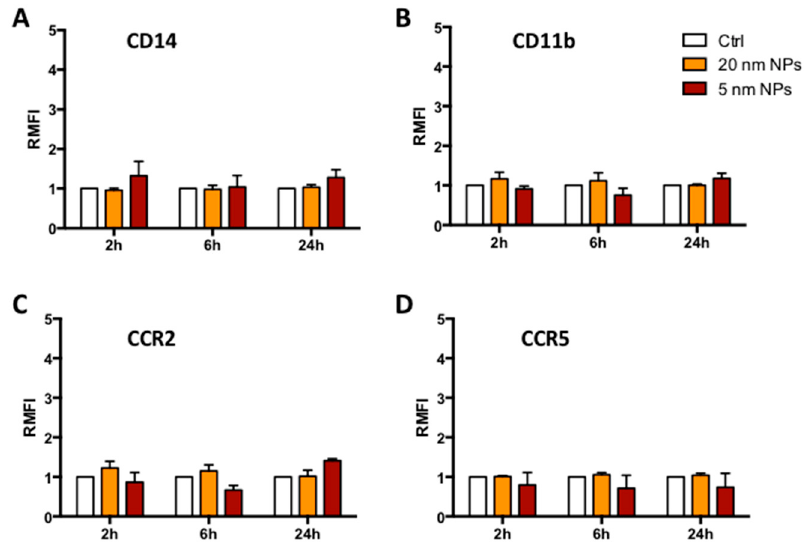
Figure 3. THP-1 receptor expression. Time dependent relative median fluorescence intensity (RMFI) evaluated by flow cytometry of CD14, CD11b, CCR2 and CCR5 after 50 μ g/mL Pt-NP treatment of THP-1 cell. Control (Ctrl, empty columns) represents untreated cells.